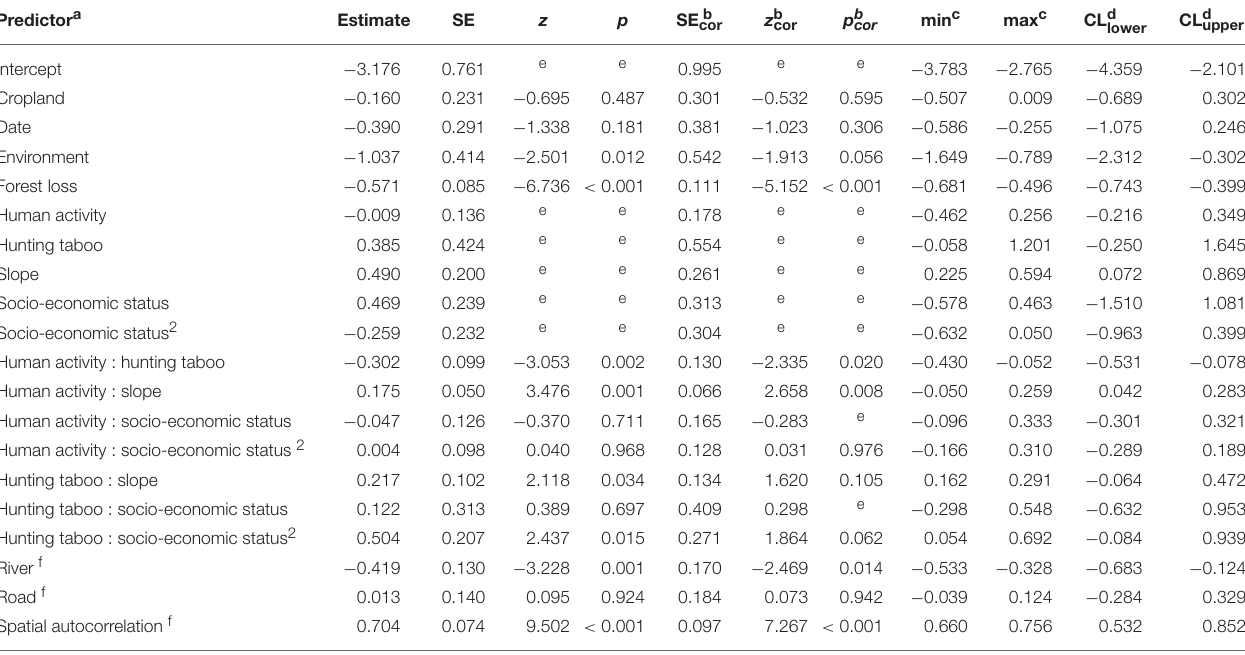
TABLE 3 | Results of the full model to identify drivers of chimpanzee densities (Generalized Linear Mixed Model, n = 17,109). Predictor a